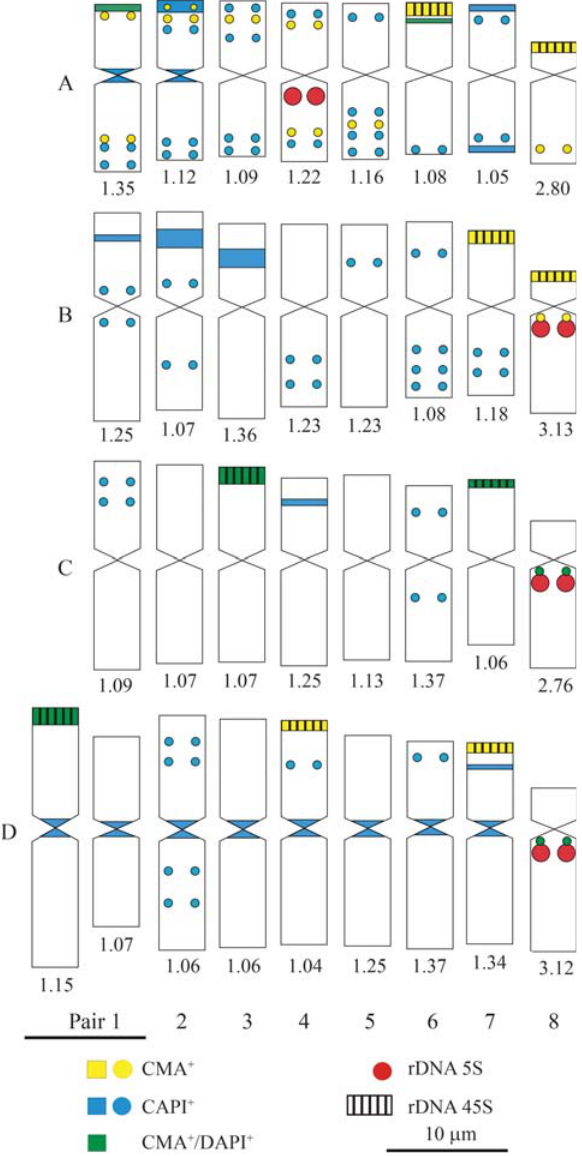
Figure 4 - Idiograms with physical location of repetitive segments in Ces- trum capsulare (A), C. corymbosum (B), C. laevigatum (C) and C. megalophylum (D). Numbers below the idiograms correspond to arm ra- tios,accordingtoGuerra(1986):metacentric(m)witharmratios( ar )from 1.00to1.49,submetacentric(sm)with ar from1.50to2.99,acrocentric(a) with ar >